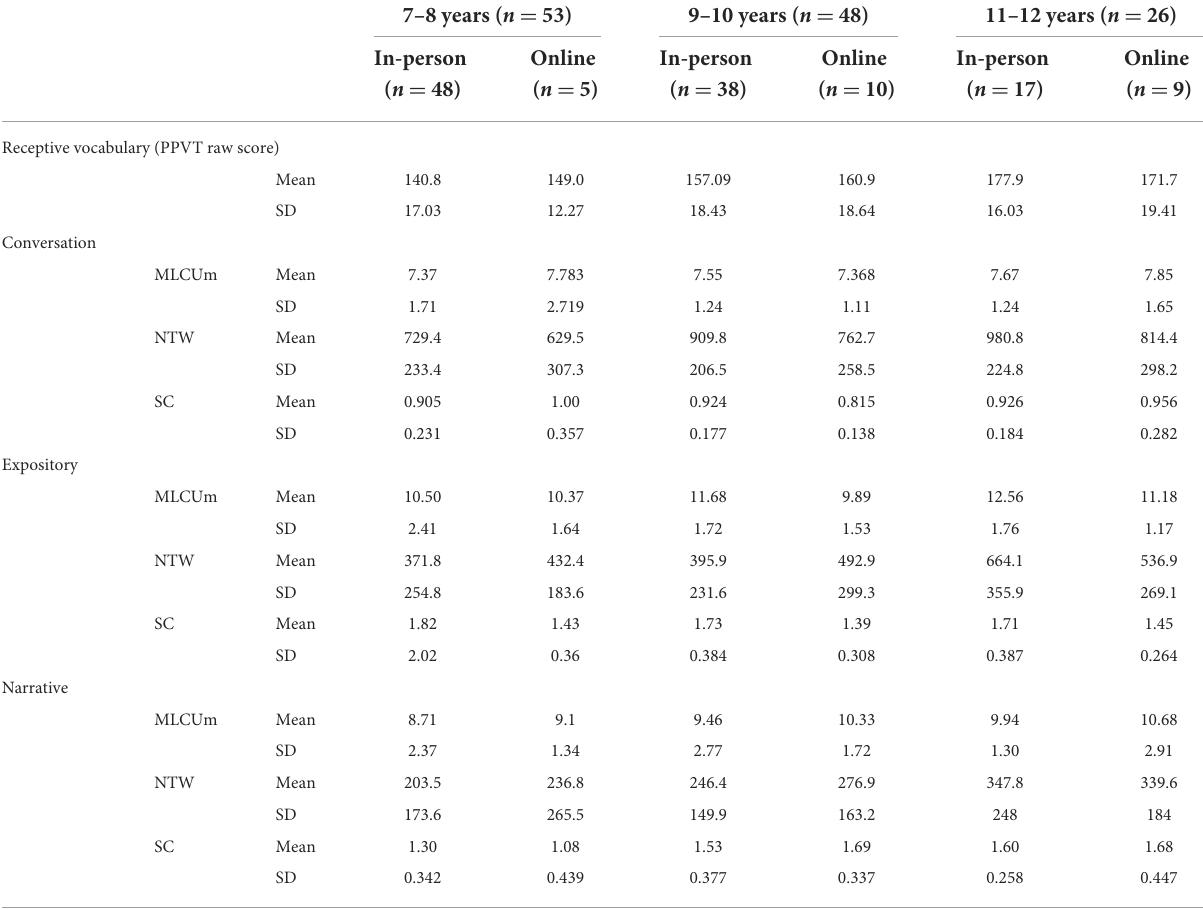
TABLE 2 Means and standard deviations of monolingual participants on all